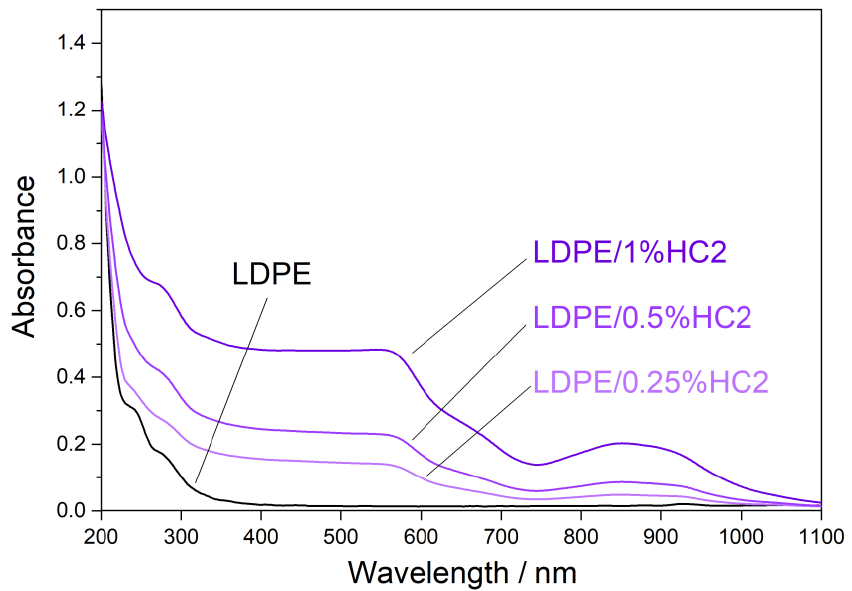
Figure 7. Absorbance UV-Vis-NIR spectra (obtained from diffuse reflectance) of LDPE and LDPE/HC2 composites.